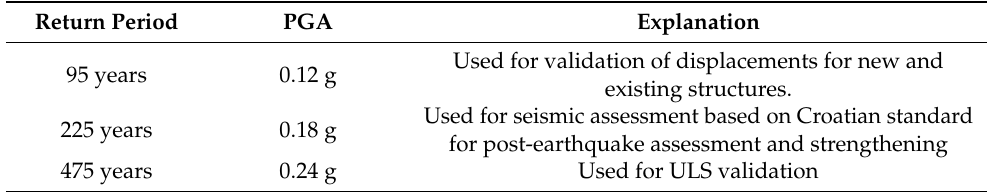
Table 4. Peak Ground Acceleration for case study building location.